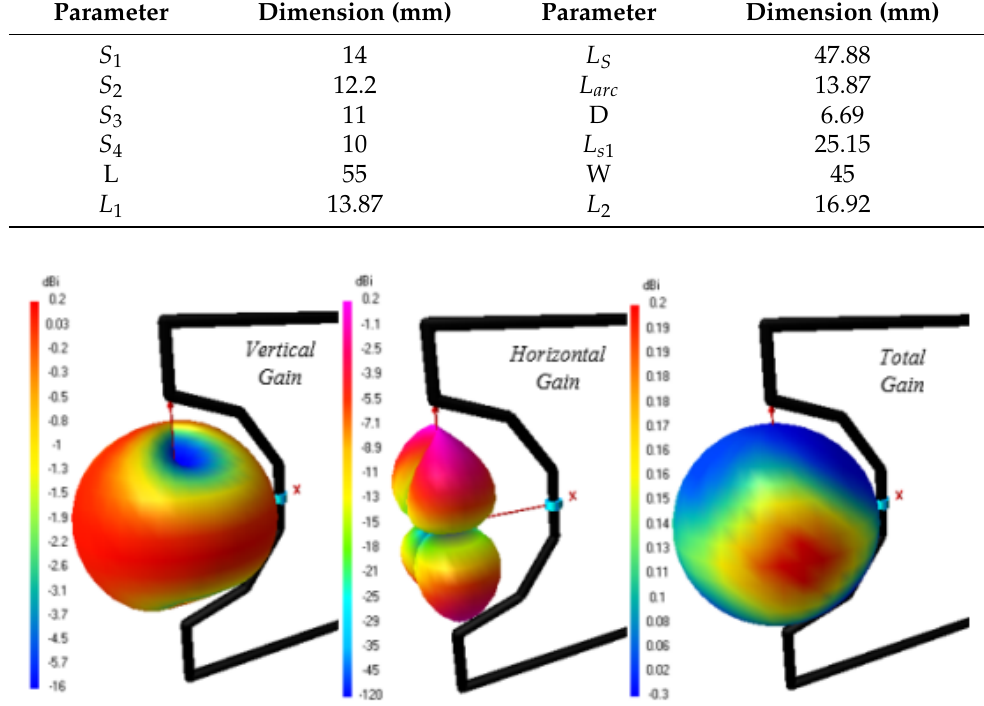
Figure 1. Structure of Near Isotropic